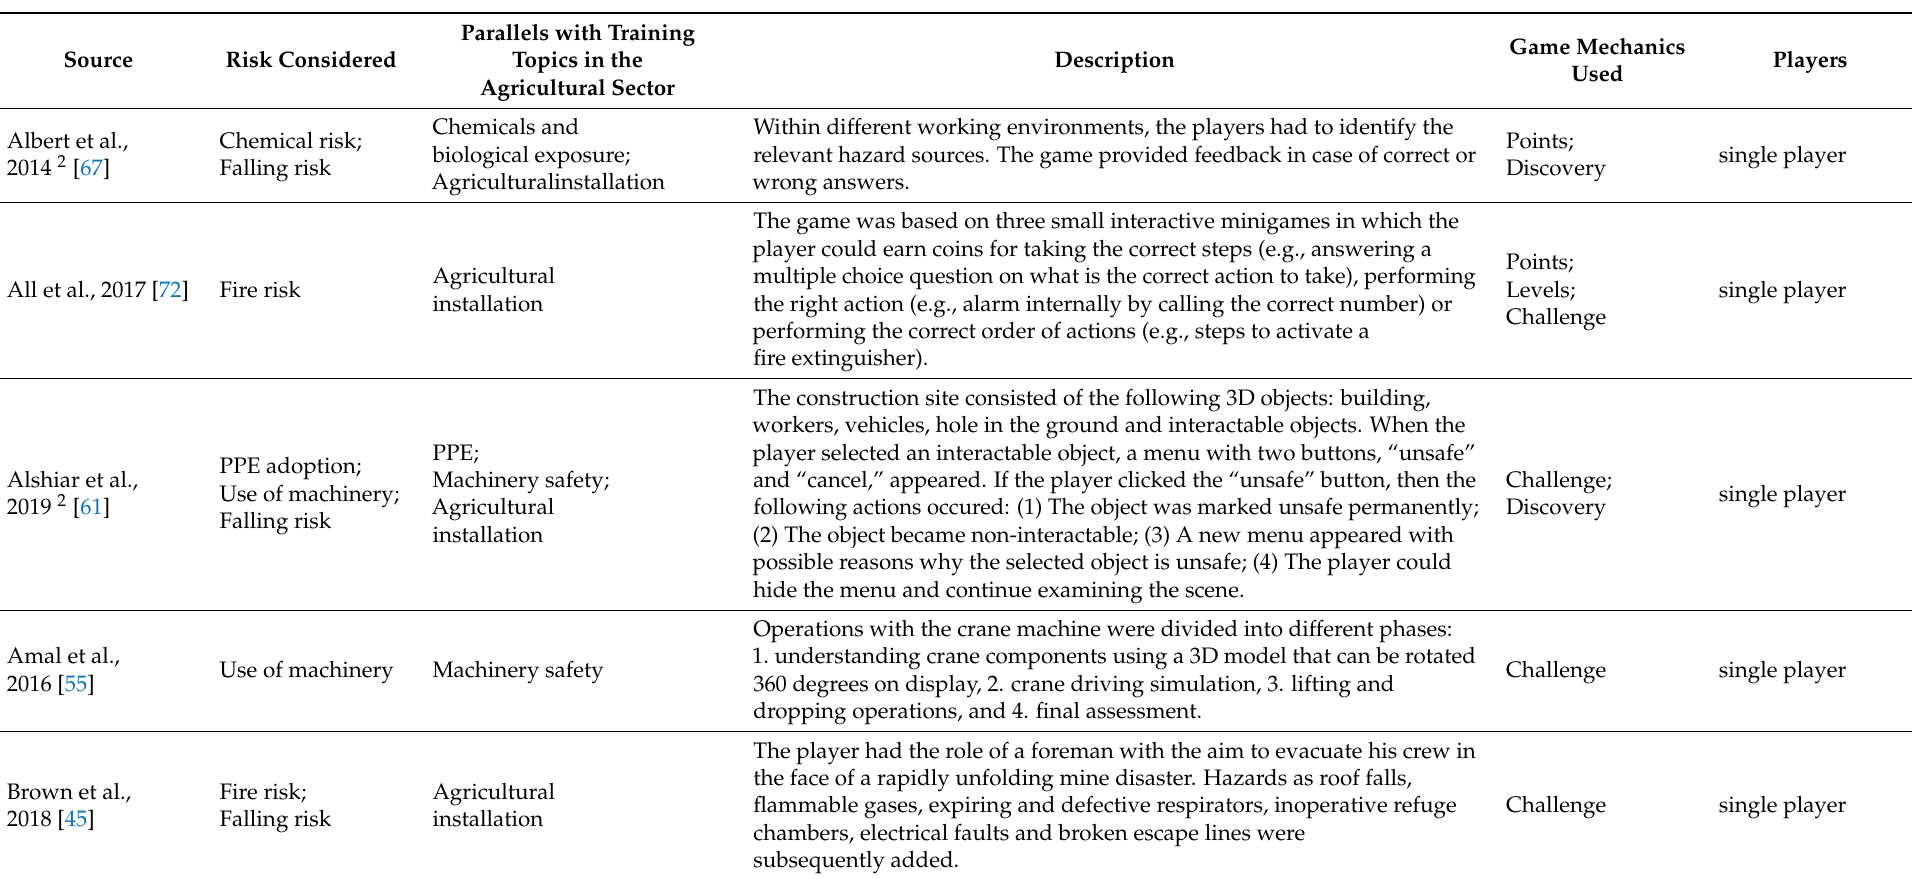
Table 1. Hazards encountered in the articles reviewed and their counterparts in the agricultural sector and the relationship between the game system and the risks discussed in the retained